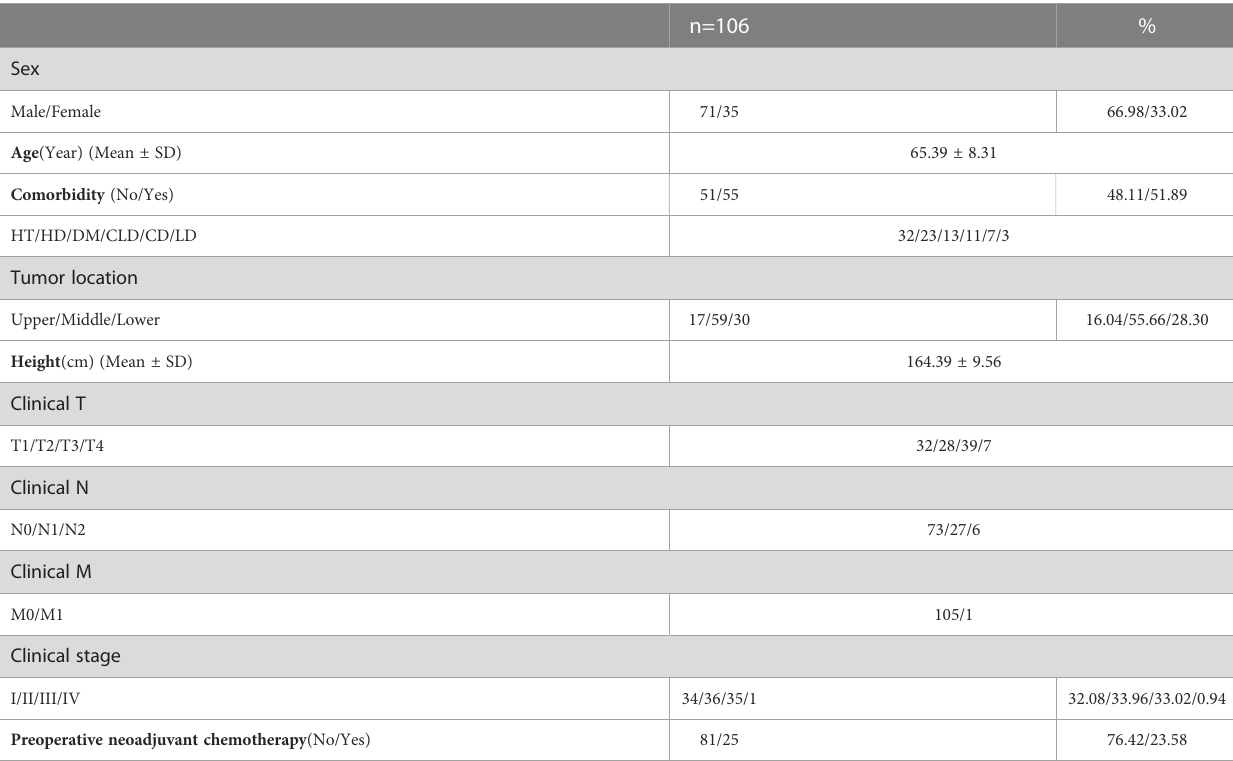
TABLE 1 Patient Demographic and clinical